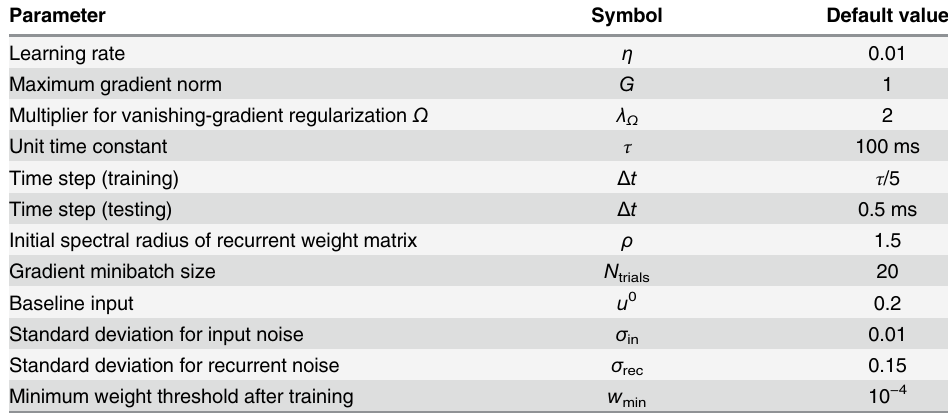
Table 1. Parameters for stochastic gradient descent (SGD) training of recurrent neural networks (RNNs). Unless noted otherwise in the task description, networks were trained and run with the parameters listed